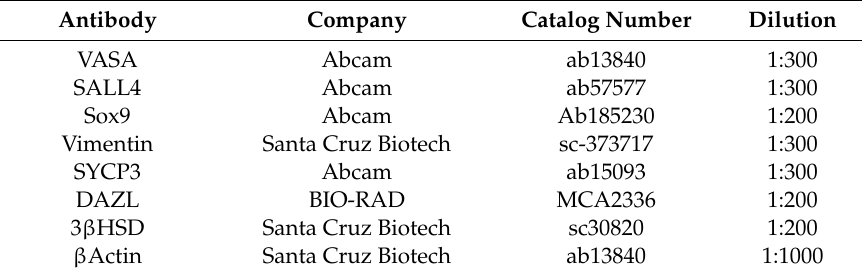
Table 1. List of antibodies used for